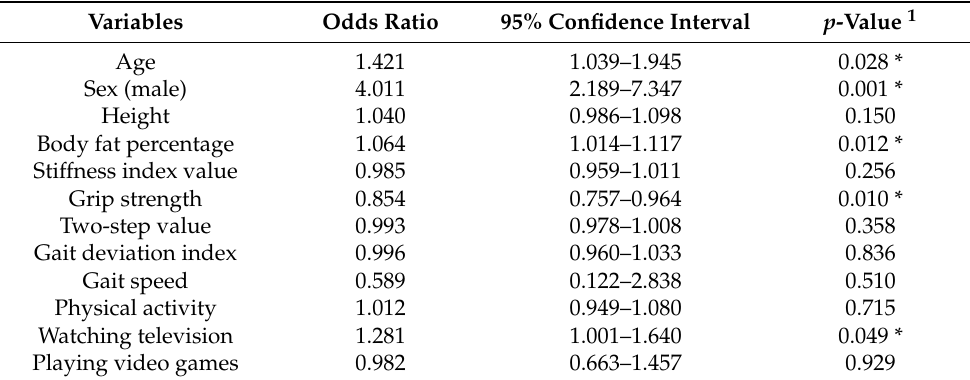
Table 3. Multivariable analysis for factors associated with locomotive syndrome among the partici- pants ( n =